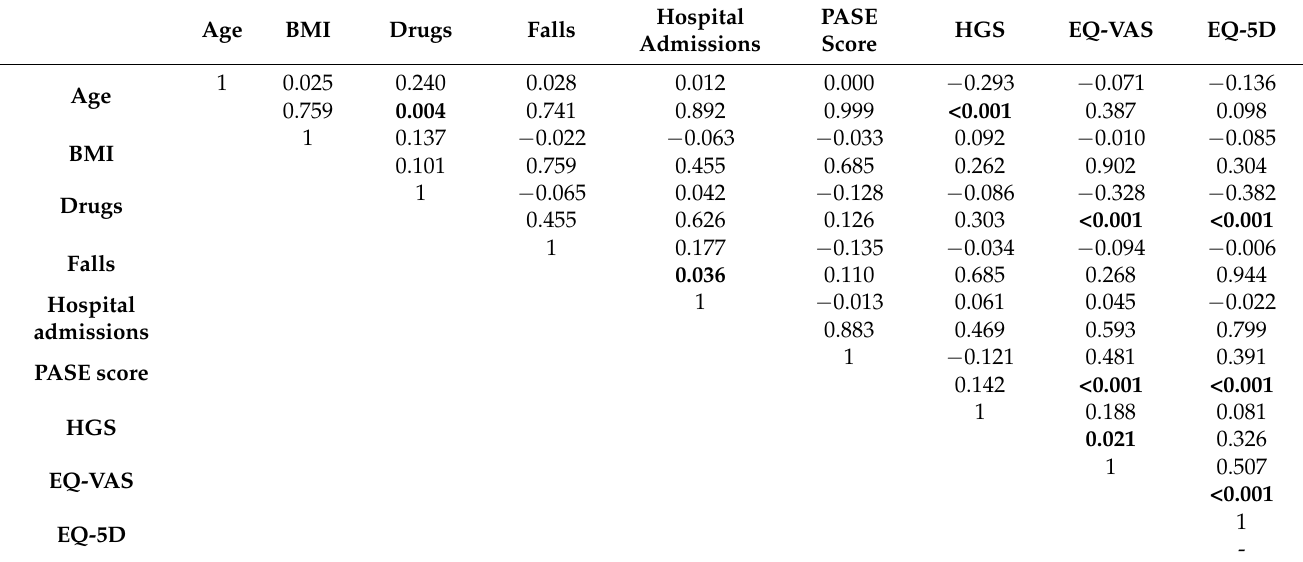
Table 3. Pearson correlation coefficients of the analyzed variables in